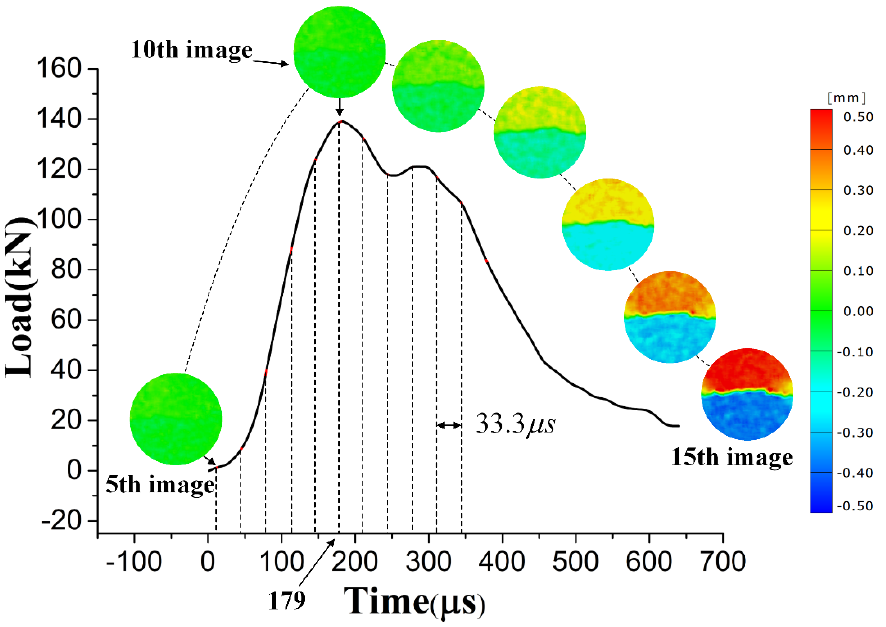
Figure 11. The relation between the images from the high-speed cameras and the load–time curve without a turning point.